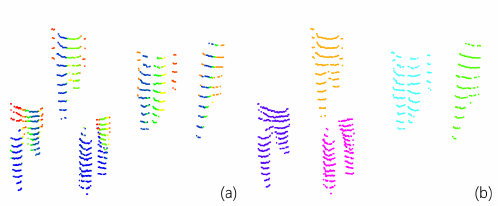
Figure 3. Example points distribution of people. (a) segmented point cloud; (b) clustered candidates. (Different colors encode different